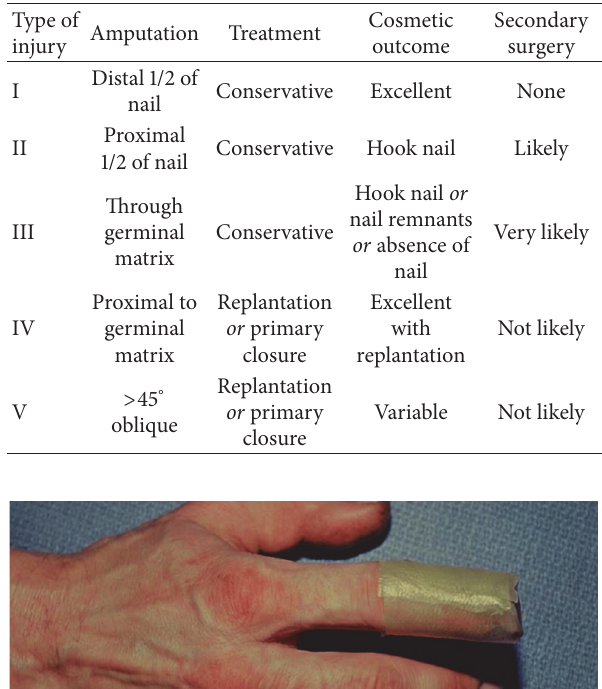
Table 1: Classification system for amputation injuries.